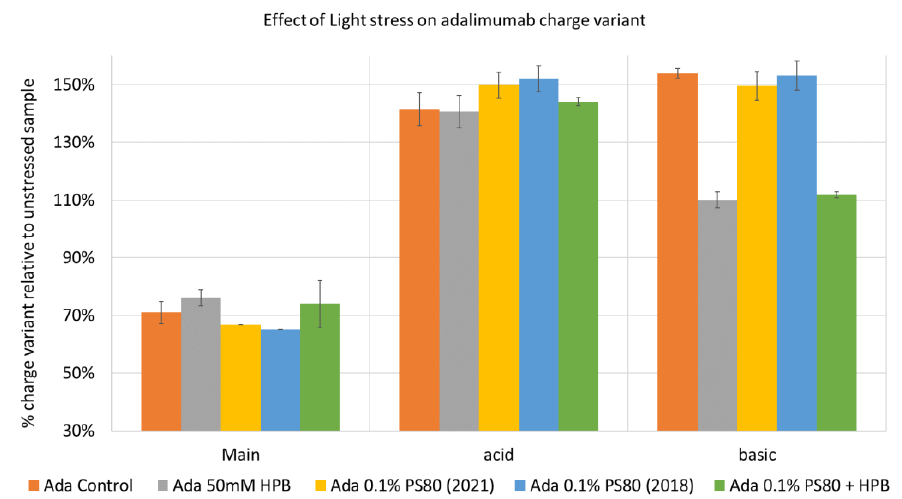
Figure 12. Adalimumab charge variants profiling under thermal and light